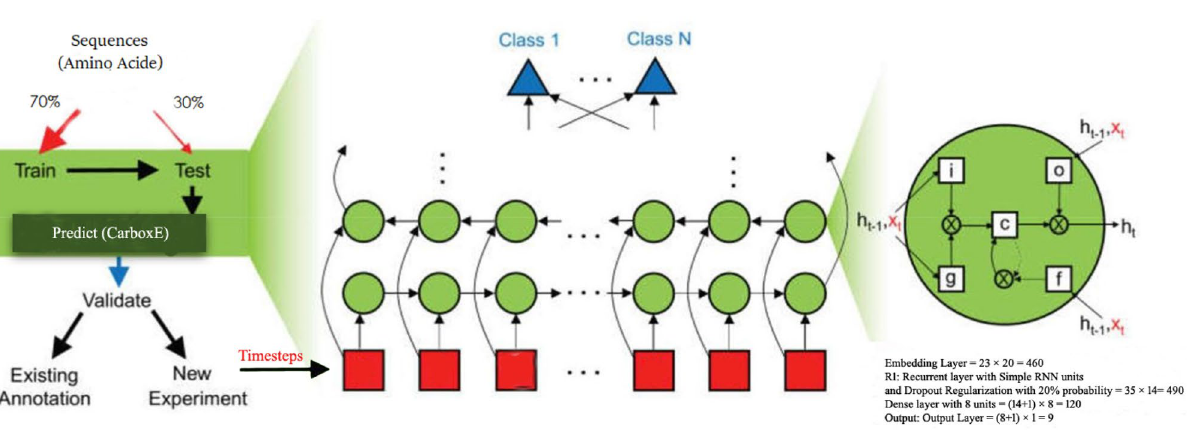
Figure 11. Architecture shared by RNNs to identify CarboxE